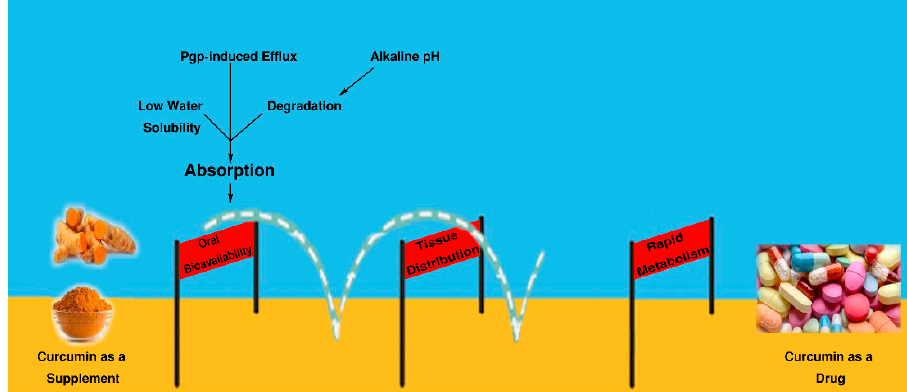
Figure 3. Obstacles against the marketing of curcumin as a drug. Challenges in curcumin oral bioavailability, distribution and metabolism, the main pharmacokinetic parameters, that emerged as major obstacles limiting the therapeutic efficacy and marketing of curcumin as a drug.